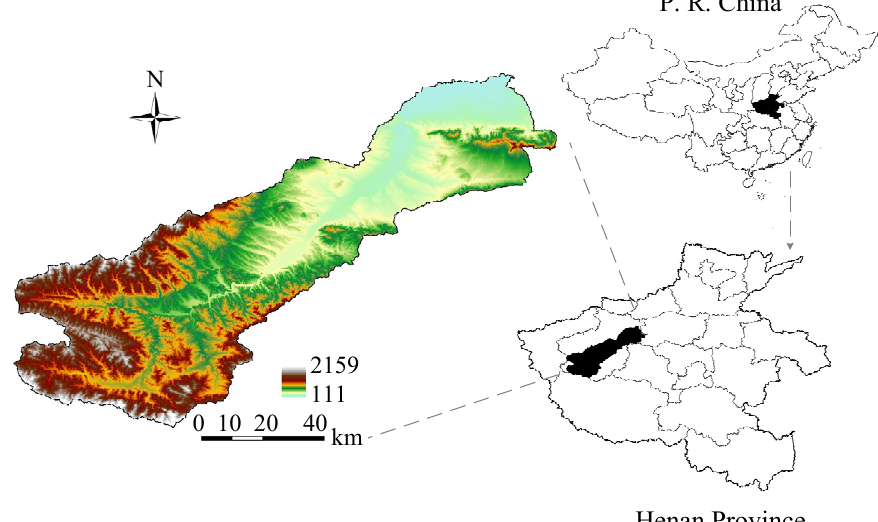
Figure 1. The location of the Yi River basin.